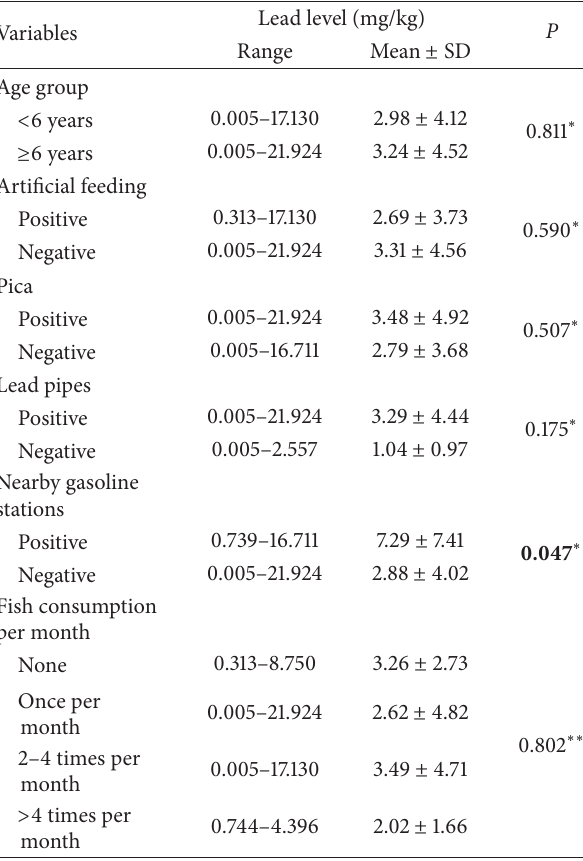
Table 4: The relationship between risk factors and mercury level among cases.